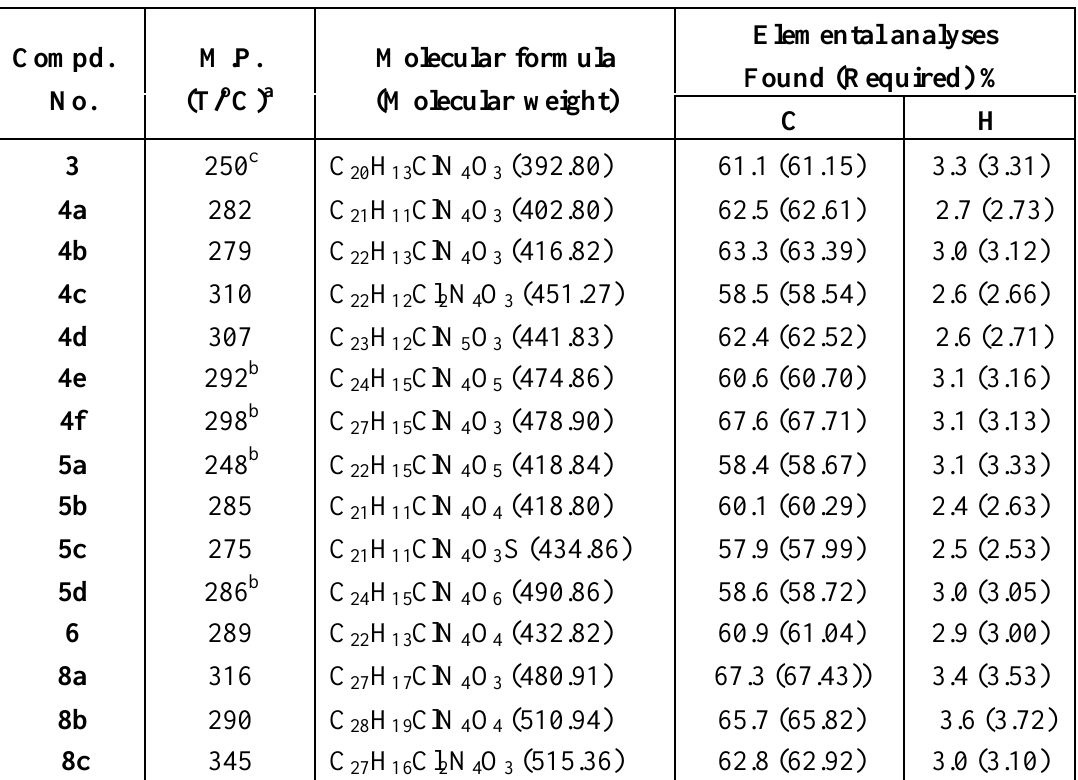
Table III: Characterization data for newly synthesized compounds